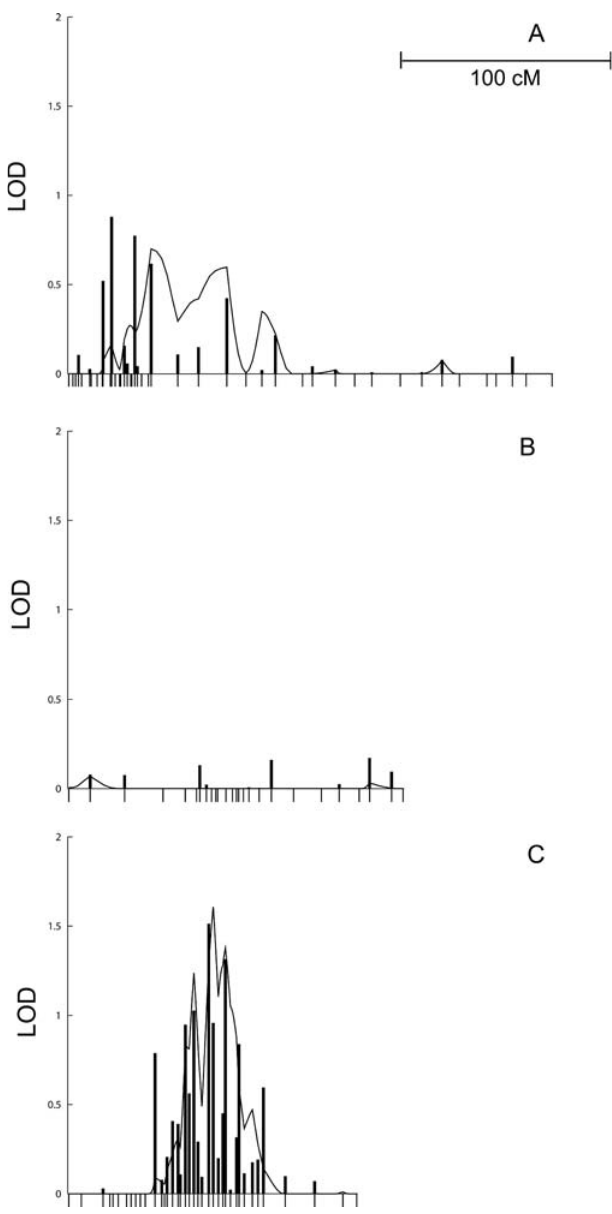
Figure 2. Replication Analysis of Chromosomes 3, 11, and 17 Linkage Peaks Replication analysis, in independent ASPs, of the three Chromosomes (3, 11, and 17) most strongly implicated by the initial genome-wide screen. (A and B) show the results for the broad CAD phenotype and Chromosomes 3 and 11 (1,194 ASPs). (C) shows the results for the narrow MI phenotype and Chromosome 17 (344 ASPs). Genetic location (abscissa) is scaled in Kosambi cM. LOD (ordinate) denotes the MLS statistic. The solid line shows multipoint LODs calculated at regular intervals; the vertical bars show single-point LODs (i.e. calculated at each microsatellite marker). The location of each microsatellite marker is shown by an external tick on the